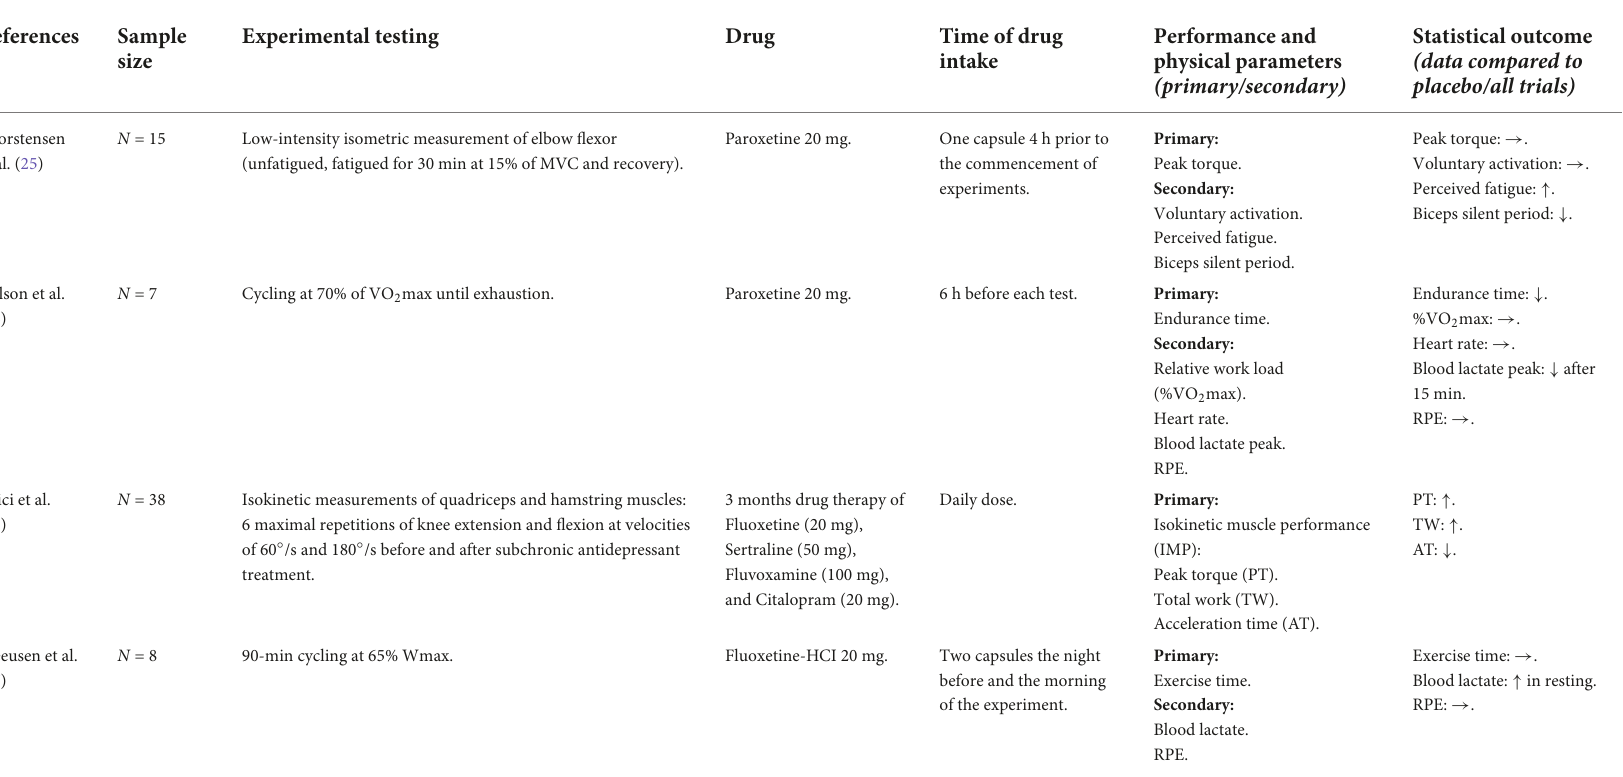
Isokinetic measurements of quadriceps and hamstring muscles: 6 maximal repetitions of knee extension and flexion at